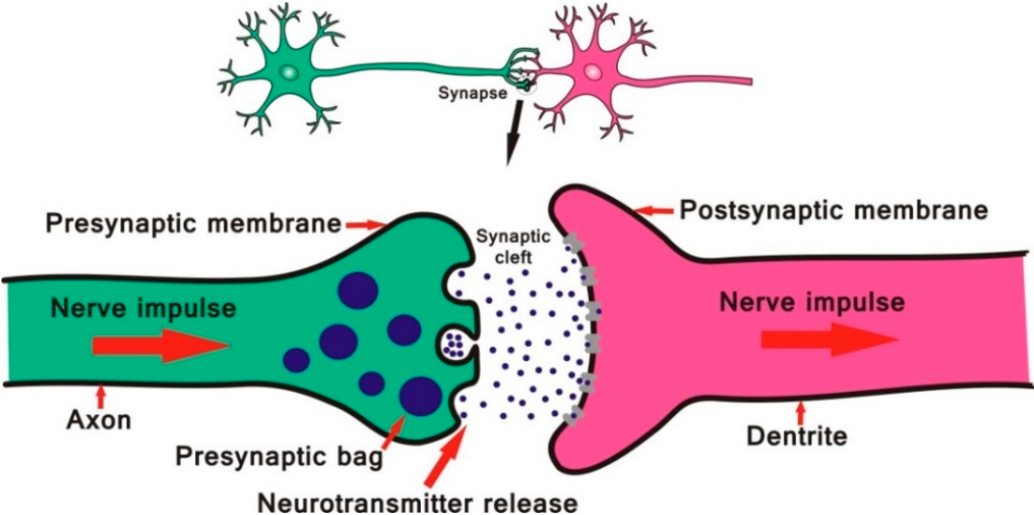
Figure 1. Neuron structure and nerve impulse transmission process.